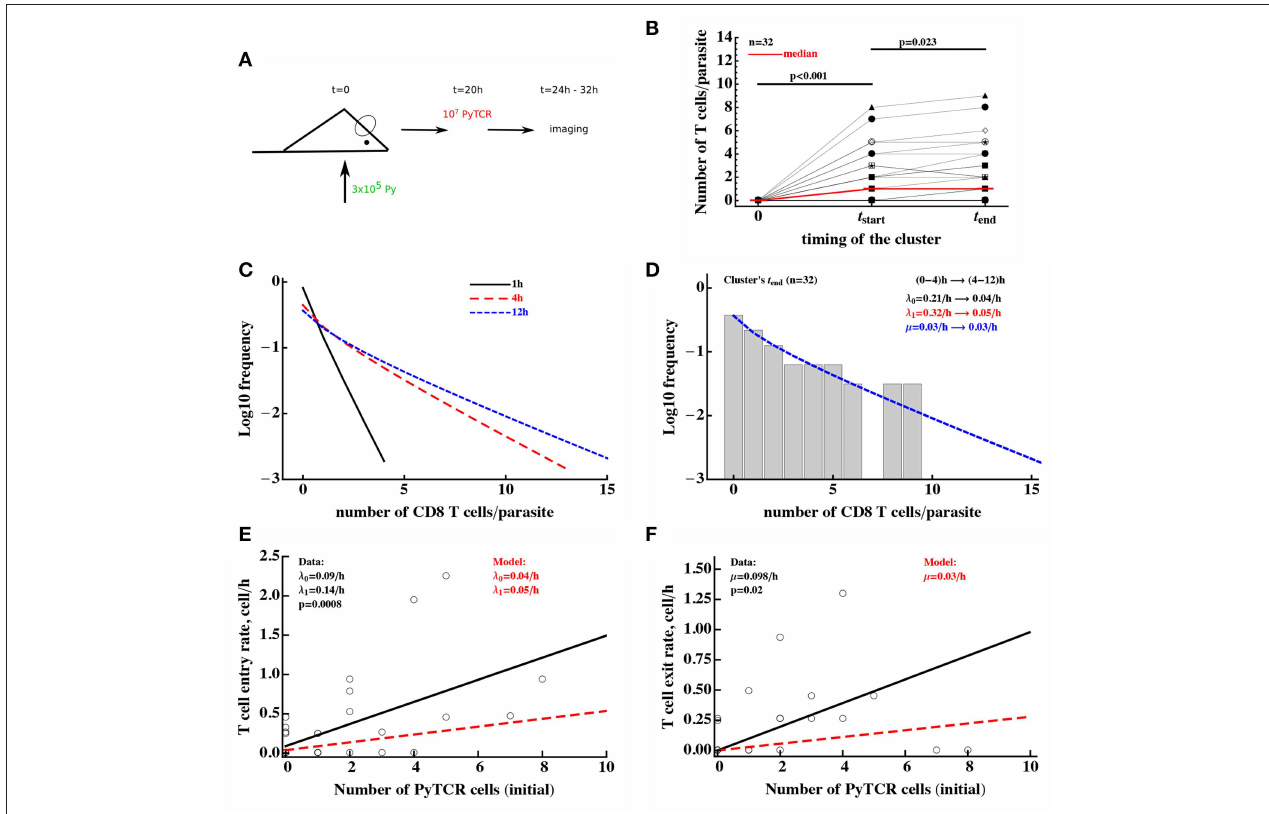
FIGURE 6 | Clusters of CD8 T cells around the parasite are largely formed by 4 h post-T cell transfer. (A) Mice were infected with 3 10 5 GFP-expressing Py × sporozoites. Twenty hours later 10 7 Py-specific activated CD8 T cells (PyTCR) were transferred into infected mice and livers of these mice were imaged using intravital microscopy between 4 and 12 h later. In total 32 parasites were randomly chosen and number of T cells in 40 µ m radius of the same parasites were counted at both times ( 29). (B) Significant increase in the median size of the cluster around Py-infected hepatocytes was observed in the first time period and there was a moderate increase in the median cluster size in the following 4–8 h (Wilcoxon sum rank test). Thick red line shows change in the median number of T cells per parasite. In these experiments, 44 and 38% of all parasites did not have a single CD8 T cell nearby for first and last measurement of T cell clusters, respectively. (C) We plot the distribution of cluster sizes as predicted by the best fit model at different times after T cell cluster 4. The best fit model was a model assuming DD recruitment Equations (1), (2) with entry rates into the cluster being dependent on the time period (0–4 and 4–12 h) but with the same exit rate during 12 h period. Estimated parameters and their 95% confidence intervals for 0–4 h time interval are λ 0 0.21 (0.11 0.34) / h and λ 1 0.32 (0.11 0.49) / h; for 4-12h time interval are = − = − λ 0 0.04 (0.0 0.10) / h and λ 1 0.05 (0.02 0.08) / h with the exit rate µ 0.030 (0.0 0.086) / h. (D) We show the observed distribution of cluster sizes at the last = − = − = − measurement for each parasite and predictions of the DD recruitment model for 12 h after T cell transfer. (E,F) Correlation between the T cell entry rate into the cluster (E) or exit rate from the cluster (F) as the function of the initial number of PyTCR T cells in the cluster. Points are experimentally measured values from Cockburn et al. (29), solid lines show the regression lines with estimated intercept λ 0 0.09 / h and slope λ 1 0.14 / h (E) or slope µ 0.098 / h (F) ; both slopes are significantly = = = different from zero ( t -test). Dashed lines in (E,F) show prediction of the mathematical model for the recruitment and exit rates estimated by fitting DD recruitment model to the clustering